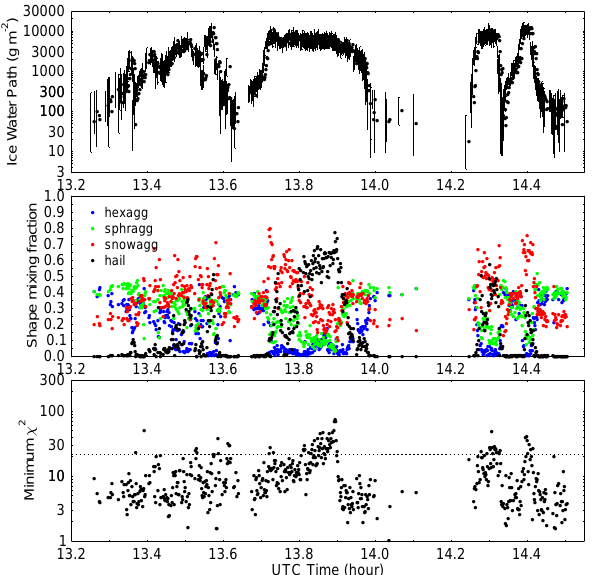
Fig. 9. Nadir retrievals of ice water path with error bars (top panel), shape mixing fractions (middle panel), and minimum χ 2 (bottom panel) for the retrieval with three particle shapes. The dotted line at χ 2 of 21.7 is the 99% significance level for 9 channels.